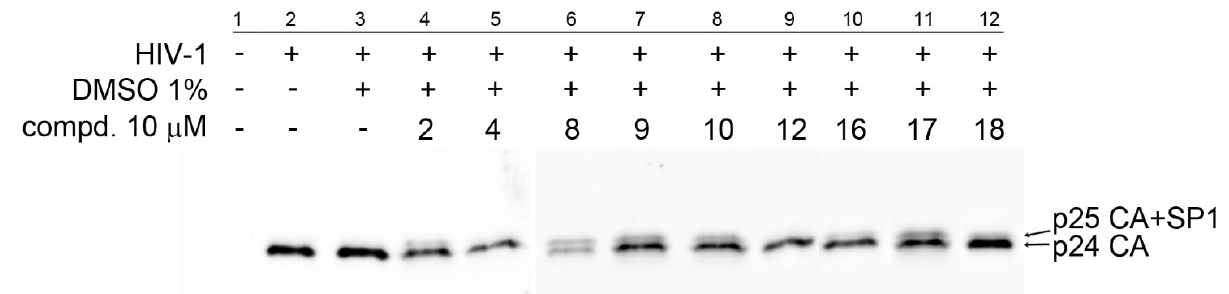
Figure 6. Effect of selected tested compounds on CA-SP1 processing of HIV-1 Gag polyprotein. HEK 293 cells produced HIV-1 particles pseudotyped with VSV-glycoproteins in the absence (lanes 2 and 3) or presence of selected tested compounds (lanes 4–12). At 48 h post-transfection, VSV-G pseudotyped HIV-1 viruses released from the HEK 293 cells were analysed by Western blot using an anti-HIV-1 CA antibody (duplicate of blot shown in Figure S57).